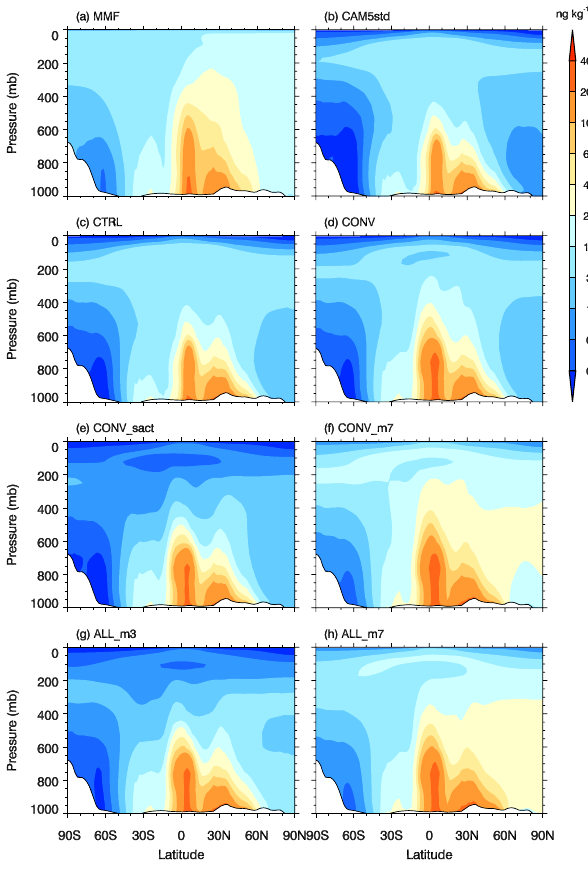
Fig. 5. Vertical and meridional distribution of DJF zonal-mean BC mass mixing ratios (ngkg − 1 ) from the various simulations. White areas between the black line and horizontal axis indicate zonal- mean topography.